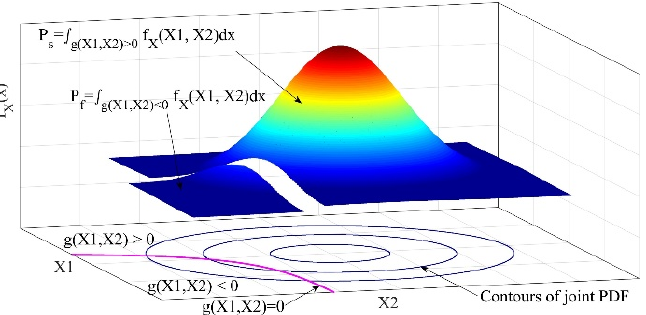
Figure 1. Visualization of a simple reliability problem consisting of 2 random variables, X1 and X2, integrand f X ( x ) and performance function g ( X1,X2 ) .